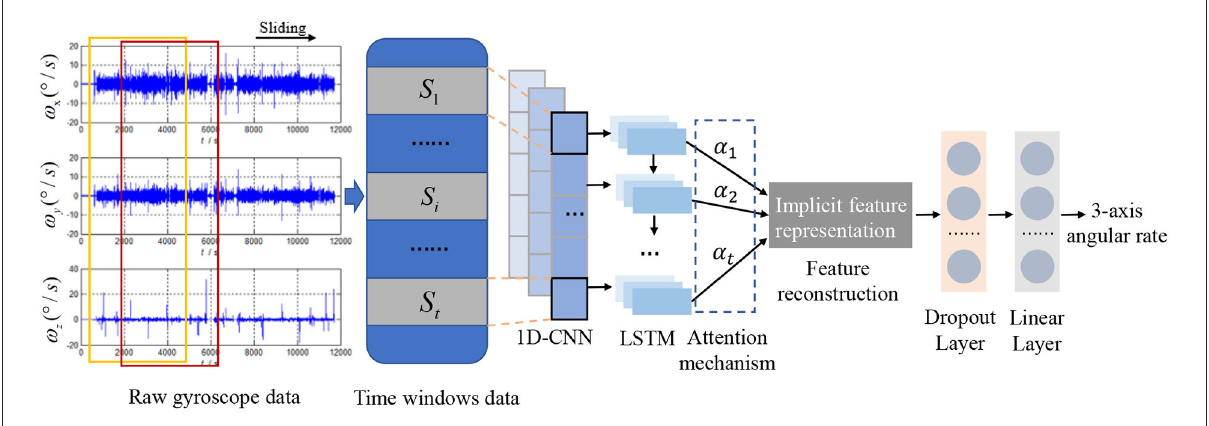
FIGURE1 The architecture of the prediction